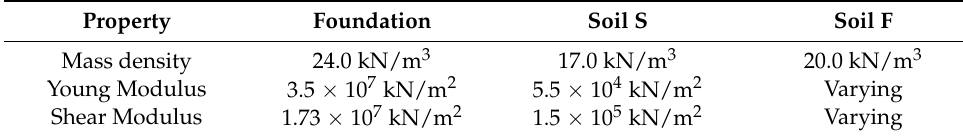
Figure 2. Schematic view of the structure and the foundation (Model B1, B2 and B3). Table 3. Geotechnical properties.